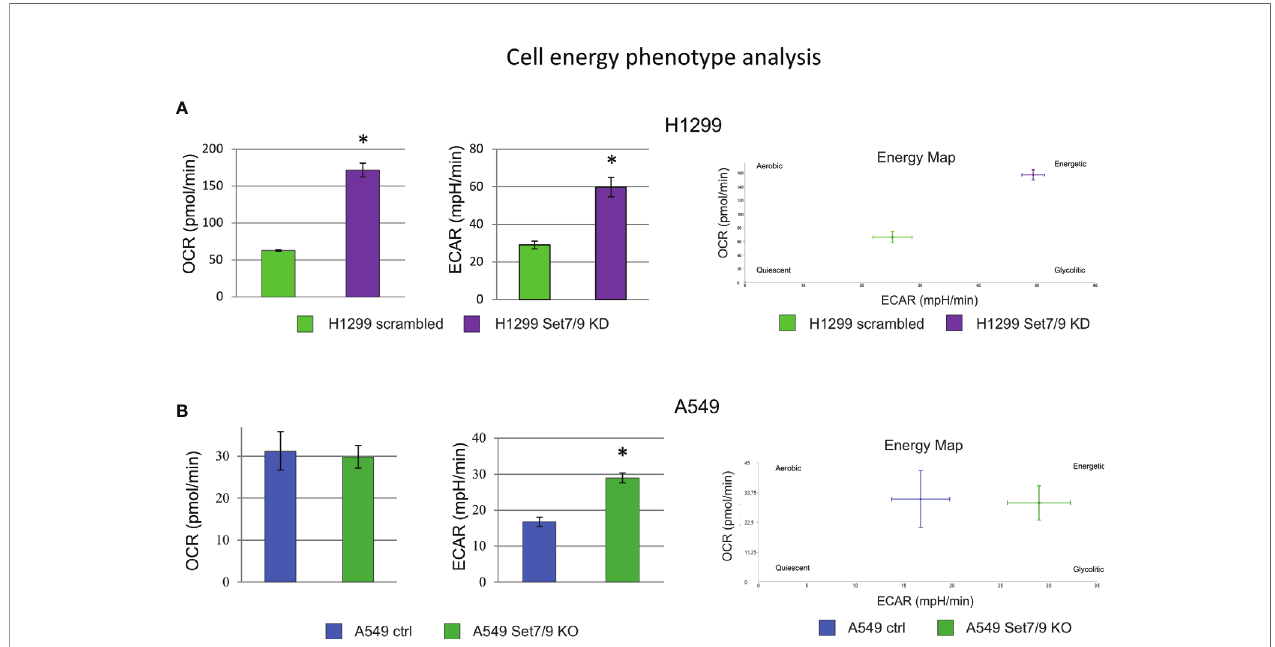
FIGURE 4 | The effect of Set7/9 decrease on cell energy phenotype of NSCLC cell lines H1299, A549 and H1975 using SeaHorse system. The analysis of the oxygen consumption rate (OCR) and extracellular acidi fi cation rate (ECAR) of NSCLC cell lines (A) H1299 and (B) A549 with Set7/9 knockdown (Set7/9 KD) and knockout (Set7/9 KO) compared to control (scrambled or vector) cells. *p <